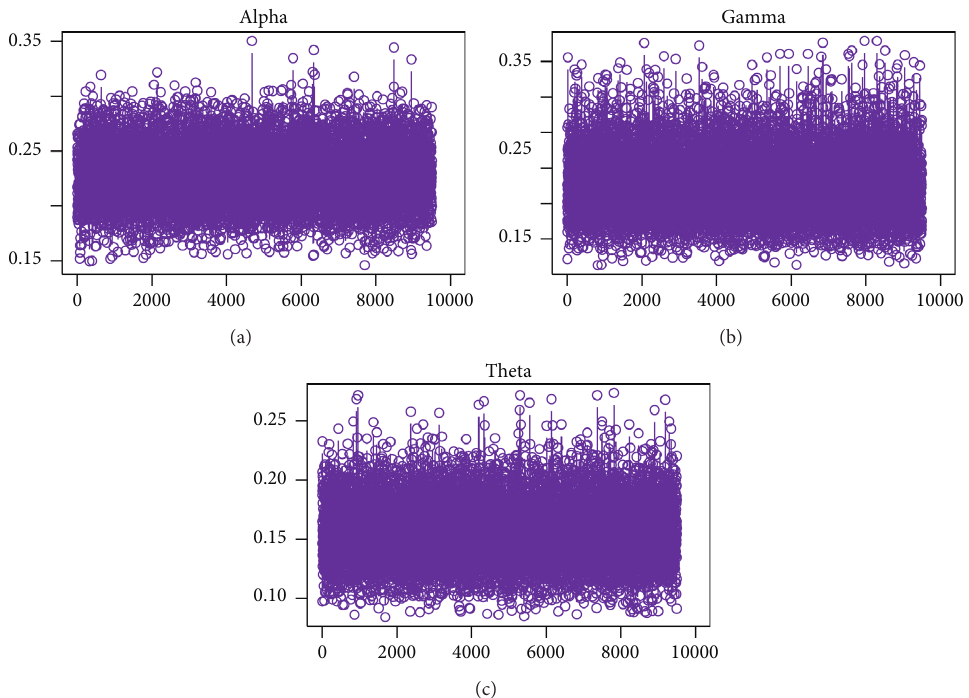
Figure 13: Trace plots of each parameter of NGE-Weibull